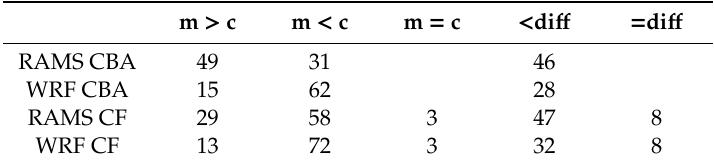
Figure 4. Averages of CBA for each 30 h period for the ceilometer (black), RAMS (red) and WRF (blue) for each month: ( a ) April, ( b ) May, and ( c ) June. Table 1. Number of cases where the model is greater than the ceilometer (m > c), less than (m < c) and equal to (m = c); and number of times when the each model has the lowest absolute difference (<diff) from the ceilometer or when the difference is equal (=diff).